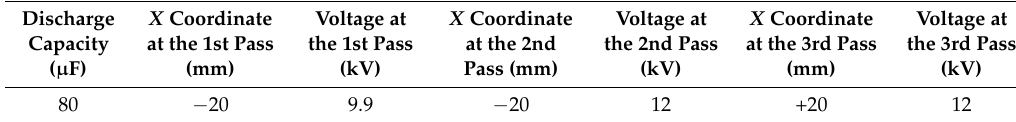
Table 4. Basic simulation conditions for